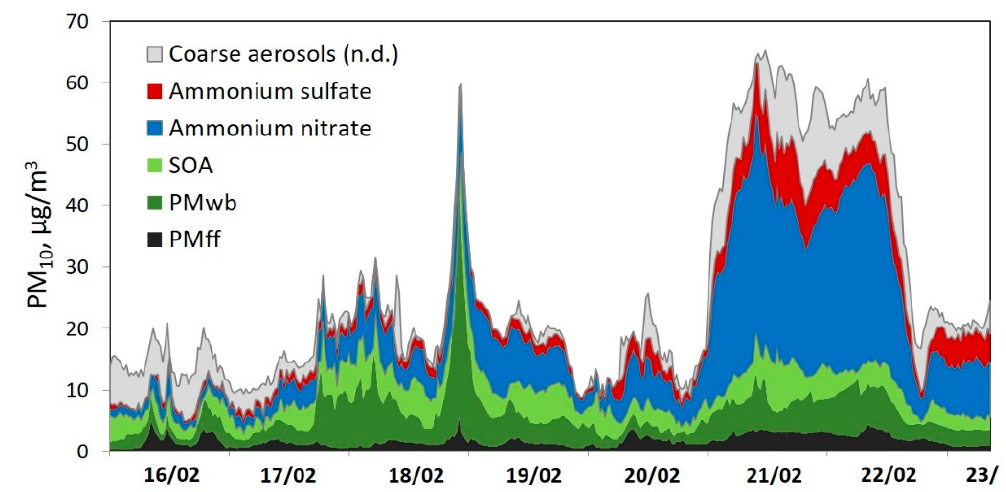
Figure 9. PM 10 chemical mass closure estimated from ACSM and AE33 measurements at SIRTA in February 2018.